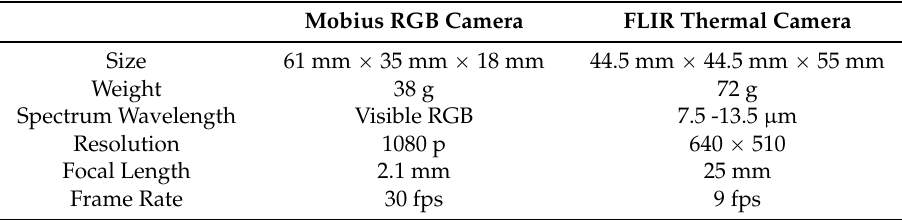
Table 1. Camera specifications for RGB and FLIR Thermal